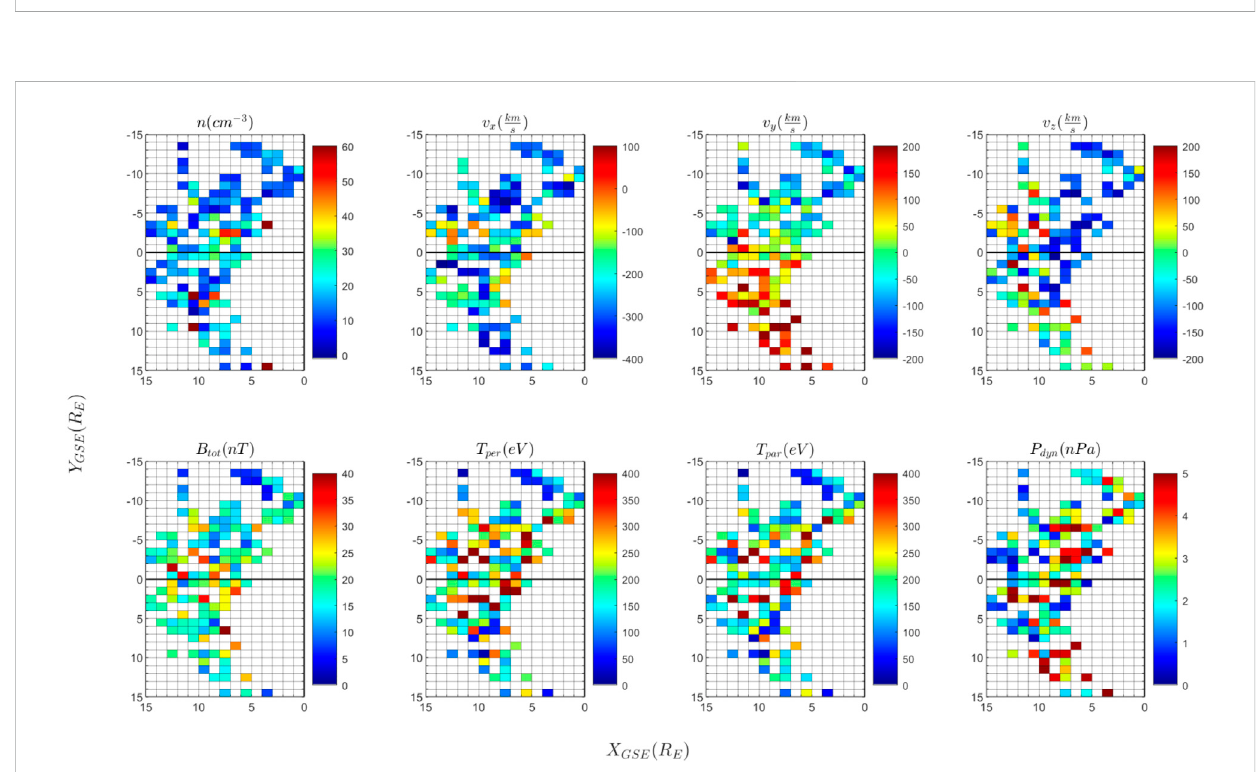
FIGURE 6 Summary of dynamical properties of magnetosheath jets observed by Cluster 3 in January – April 2008. Same format as Figure